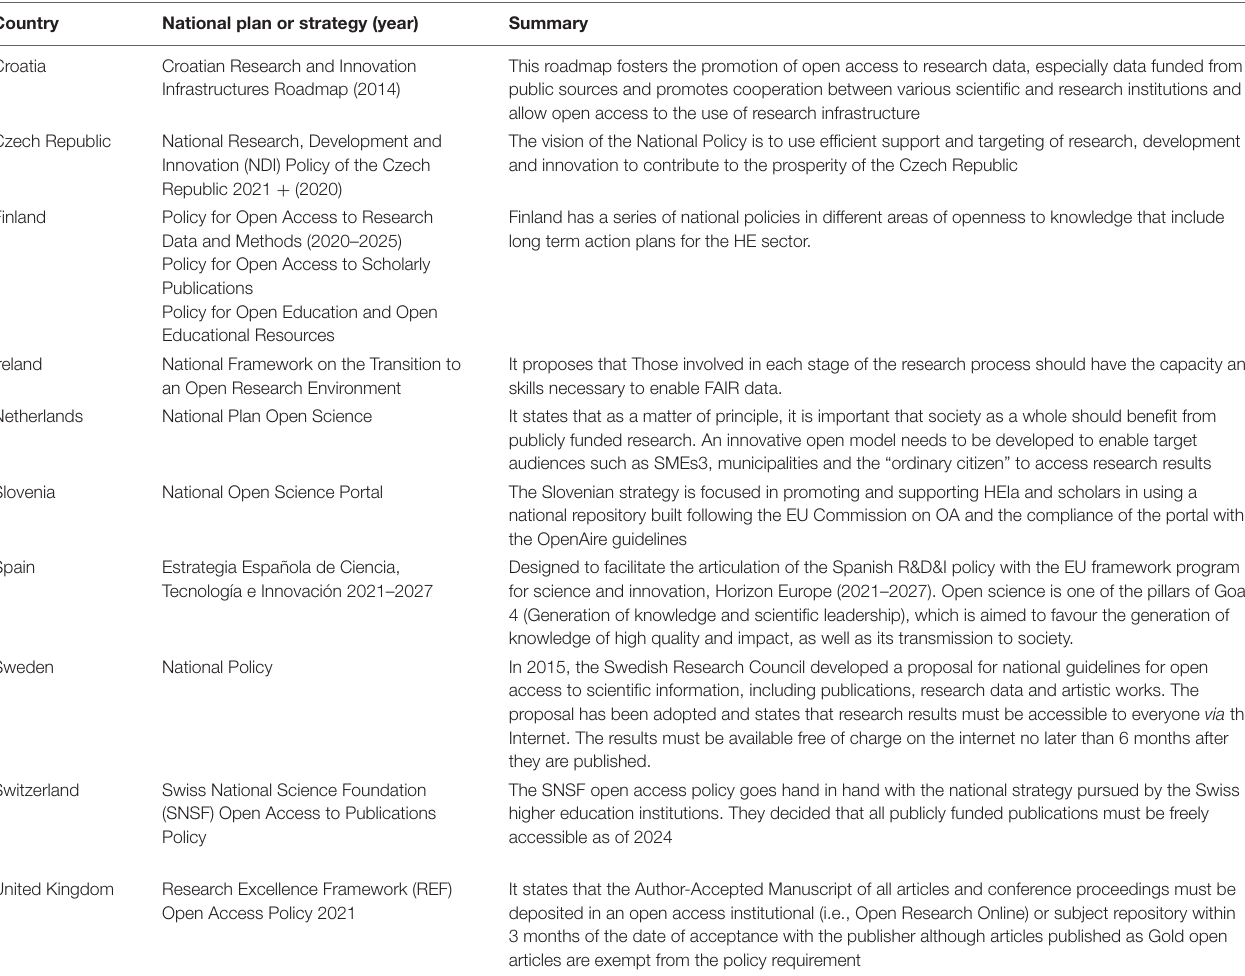
TABLE 2 | National policies, action plans, or strategies to promote OA, OSC, or